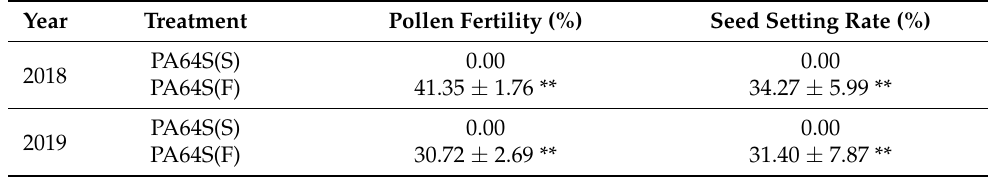
Figure 1. Plant morphology and characteristics of the anthers and pollen in sterile Peiai64s (PA64S(S)) and fertile Peiai64s (PA64S(F)). ( A , C , D ): pictures of plant morphology, pollen staining, and spikelets in PA64S(S), respectively; ( B , E , F ): pictures of plant morphology, pollen staining and spikelets in PA64S(F), respectively. Table 1. Pollen fertility and seed-setting rate of